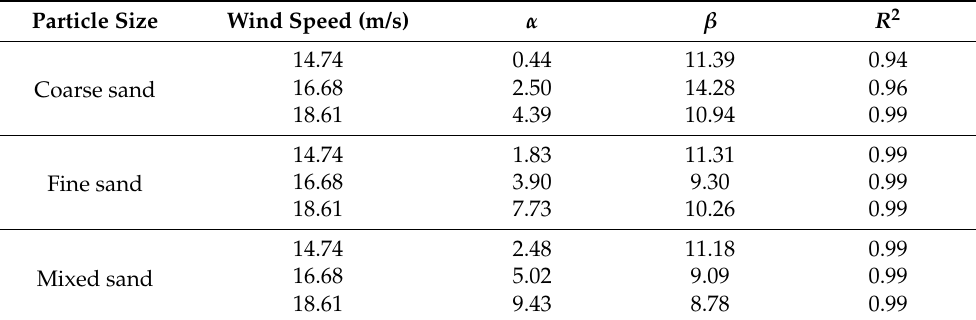
Table 4. The correlation between the impact pressure of sand particles and height. Particle Size Wind Speed